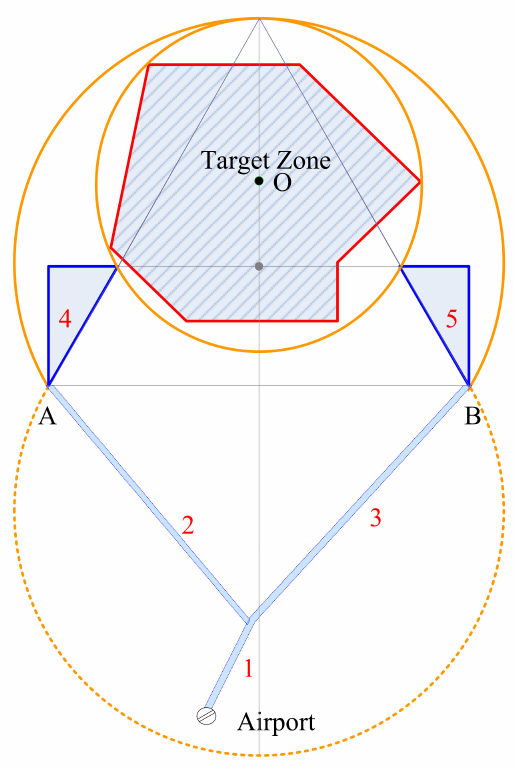
Figure 8. Optimal airspace distribution in time difference localization (Airspaces 4 and